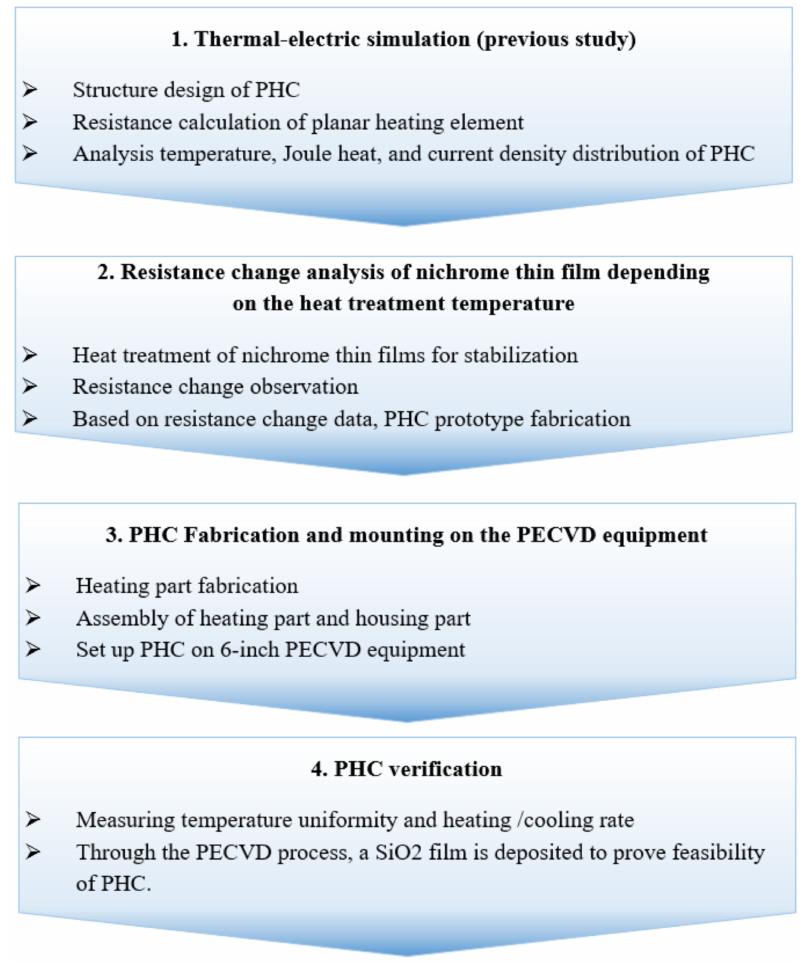
Figure 3. Process flow for PHC